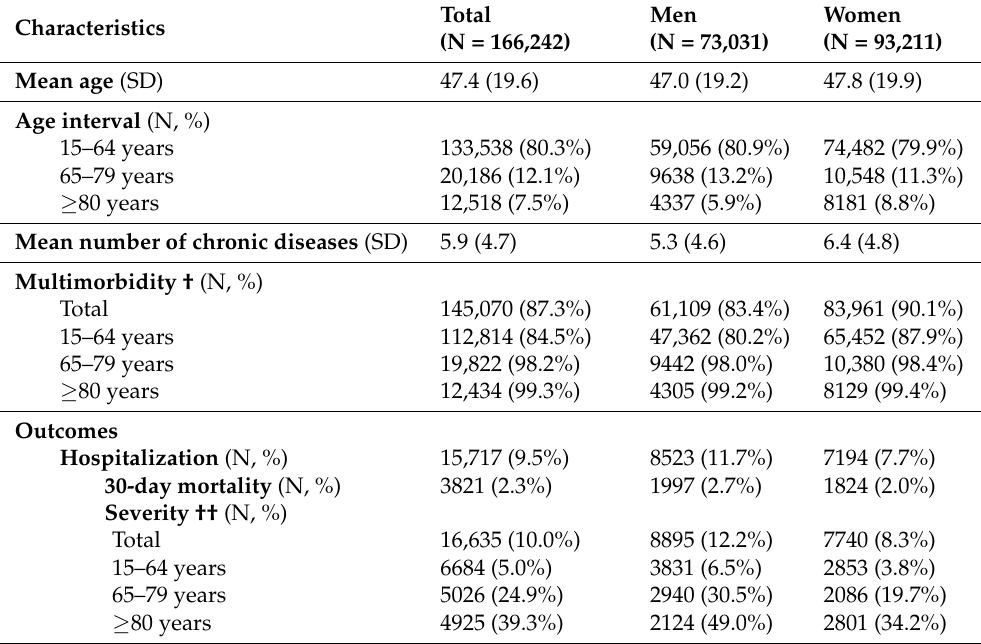
Table 1. Demographic and clinical characteristics of individuals aged 15 years or older with COVID-19 infection in the Andalusian Population Health